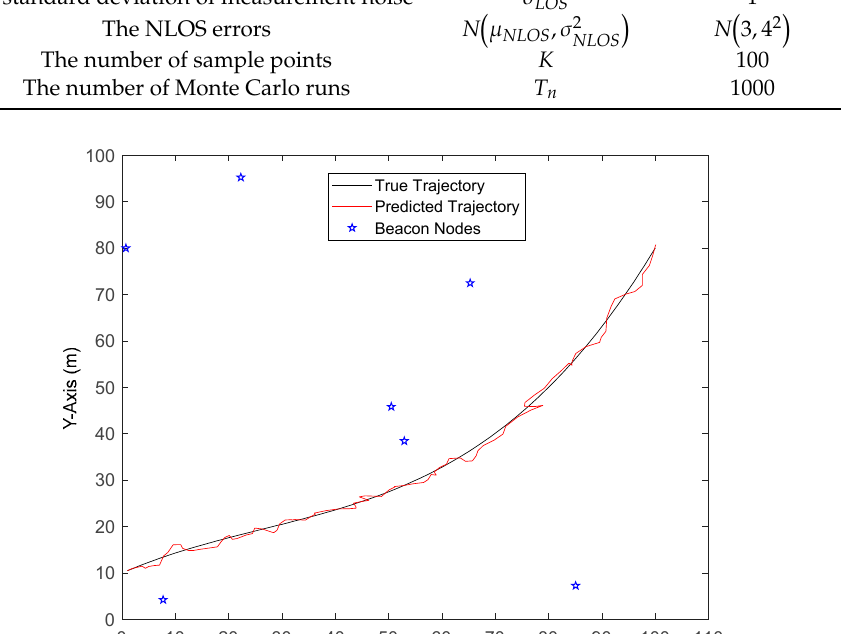
Figure 3. The localization result of REKF-TQ.